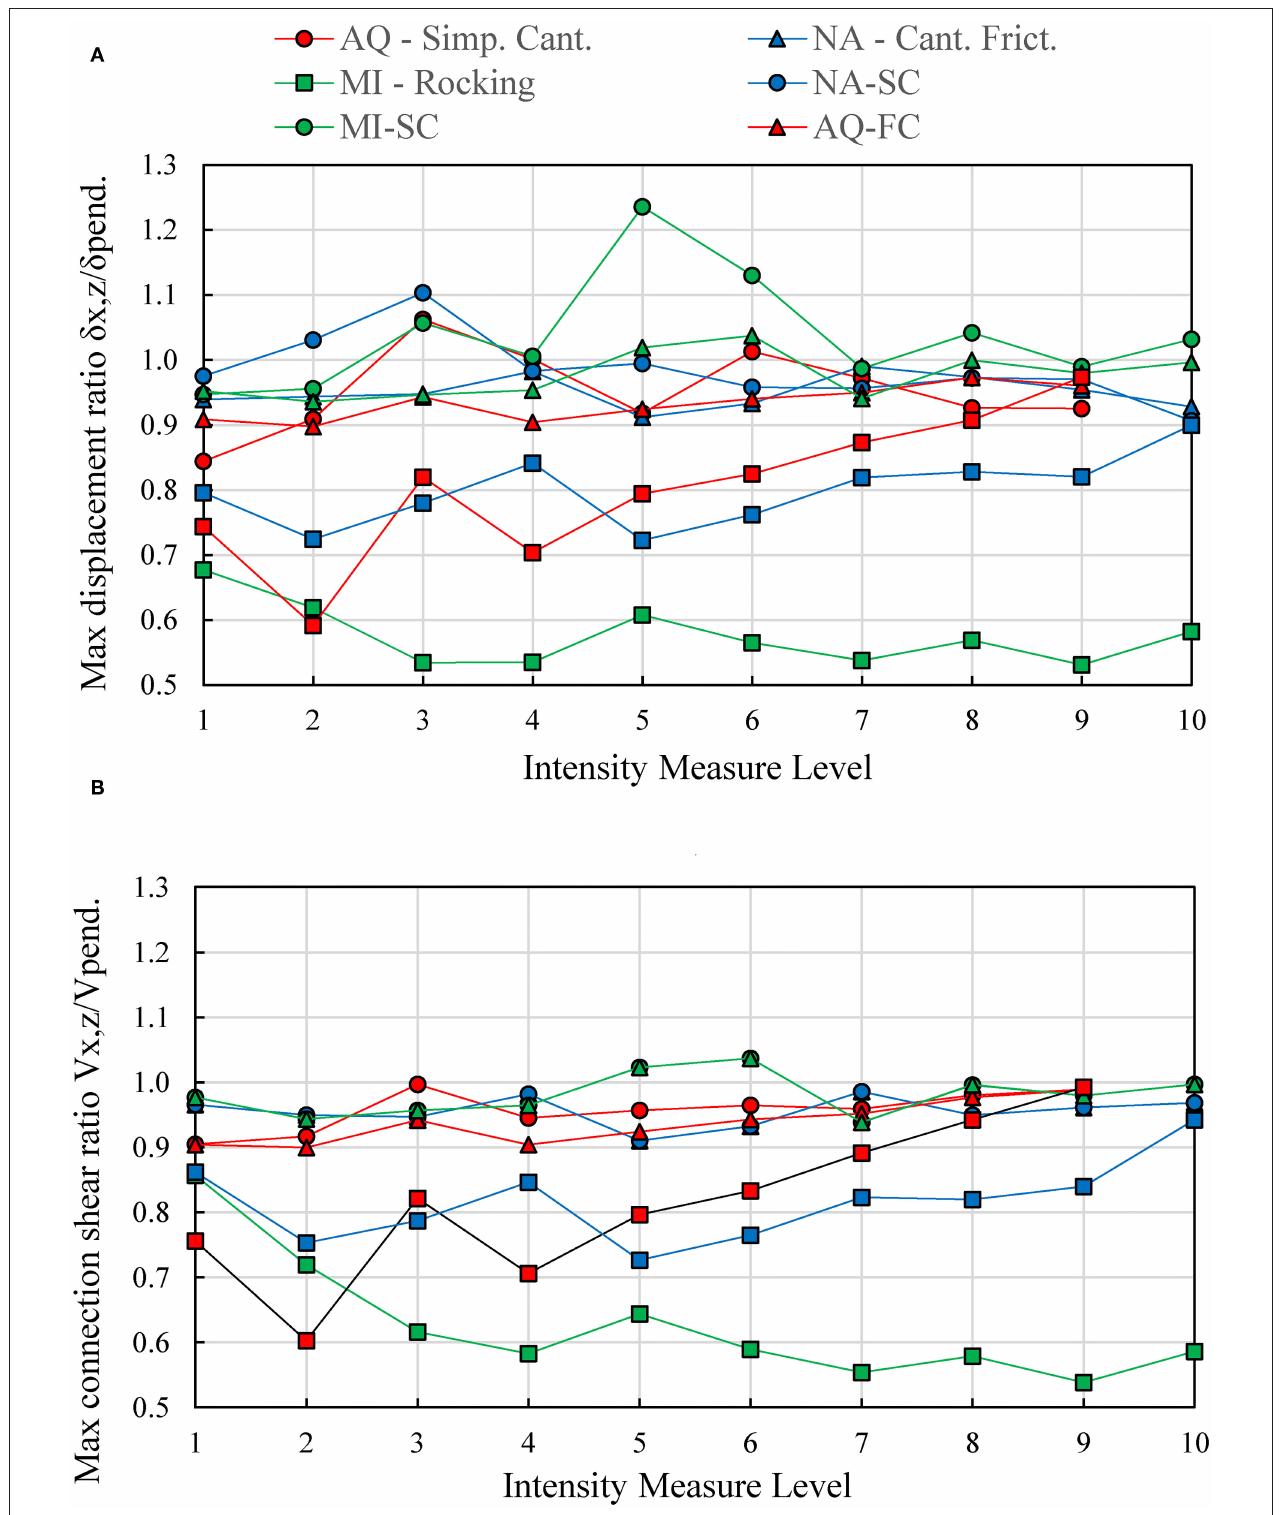
FIGURE 10 | Performance ratio of the other panel connection systems over the pendulum system: (A) displacement and (B) local shear.